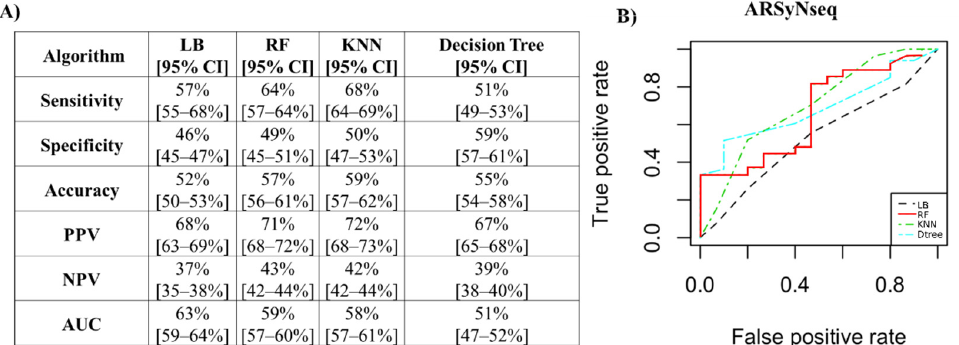
Figure 7. Performance measures to classify patients with positive biopsies for the ComBat method. ( A ) Algorithm performance via PCs to classify patients with positive biopsies for the ComBat method. ( B ) ROC curves of the four classifiers. PPV: positive predictive value; NPV: negative pre- dictive value; AUC: area under the curve; LB: LogitBoost; RF: random forest; KNN: k-nearest neigh- bors; CI: confidence interval.